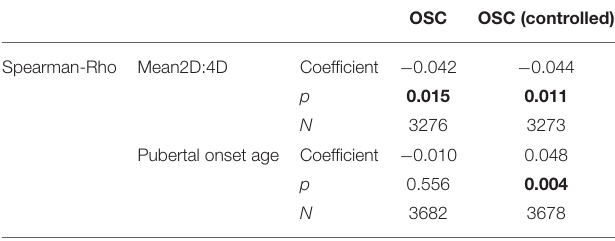
TABLE 2 | Post hoc analysis of 2D:4D OSC OSC (controlled)